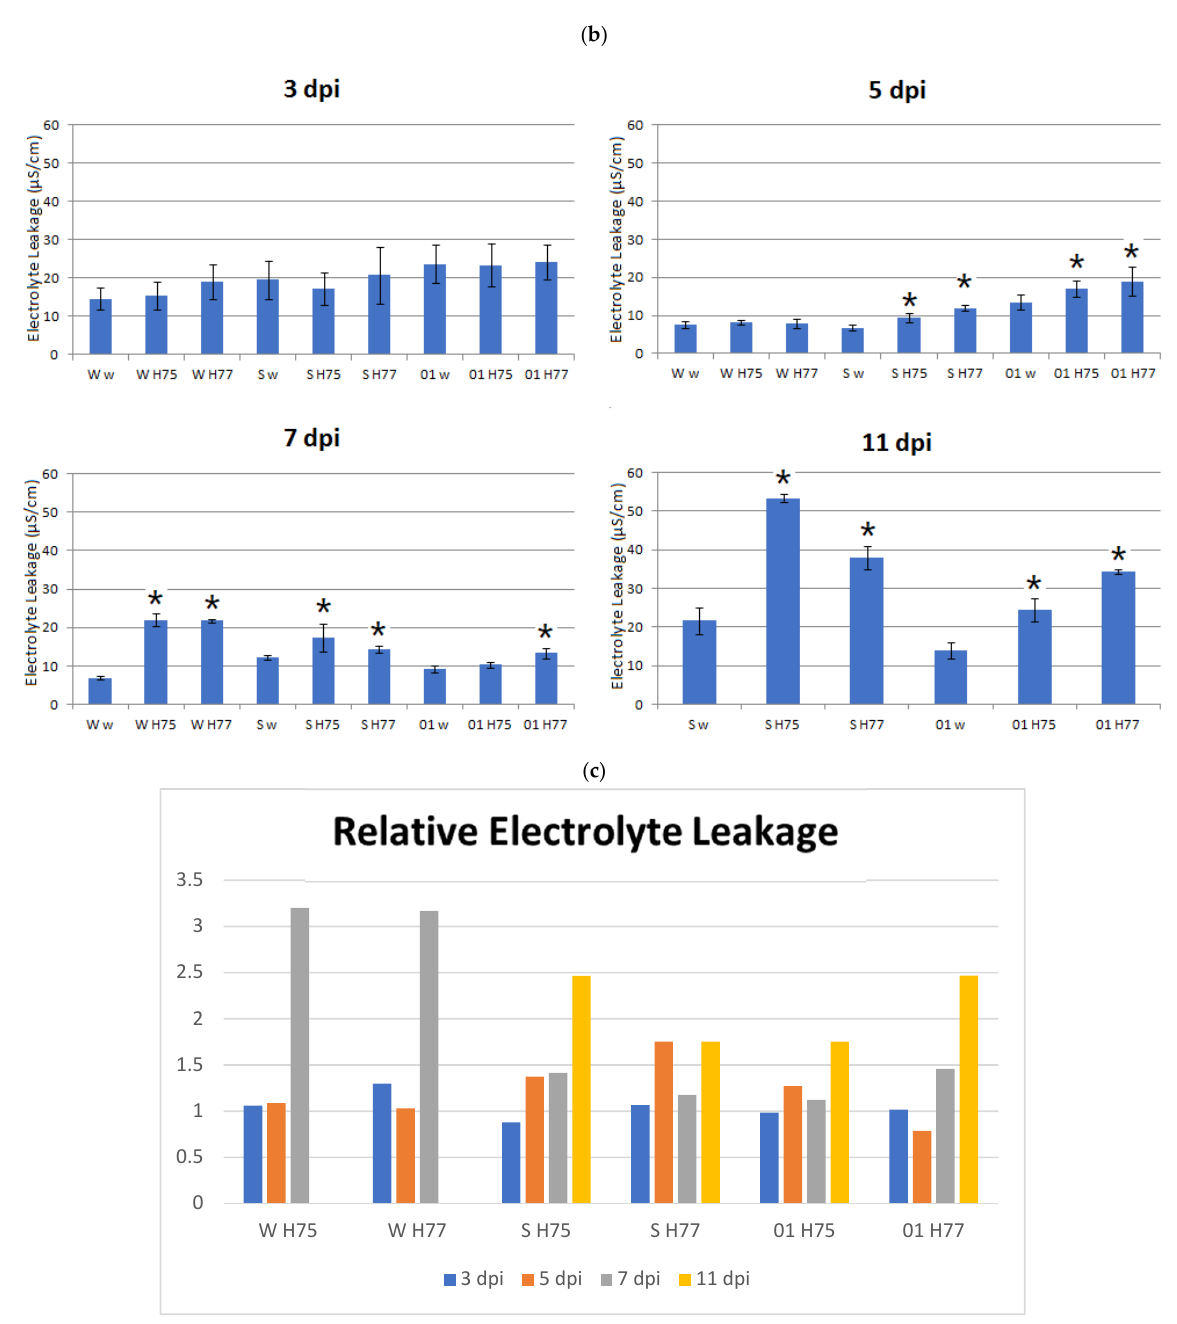
Figure 1. ( a ) The lesion development and the appearance of phenotypes were observed from the three genotypes (Westar, Surpass400 and 01-23-2-1) and two isolates (H75 8-1 and H77 7-2) at 11 days post-inoculation (dpi). ( b ) The measurement of electrolyte leakage at 3, 5, 7, and 11 dpi. At 11 dpi, because Westar cotyledons were generally degraded and heavily infected, the measurement of electrolyte leakage at this stage became incapable and inaccurate, the measurement of Westar genotype at this time point was not included. The x-axis indicates the inoculation pair between genotypes (W: Westar; S: Surpass400; 01: 01-23-2-1) and isolates (w; water; H75: H75 8-1; H77: H77 7-2), the y-axis indicates the voltage detected from the cotyledon-soaked solution suggesting the leaking of ions (unit: µS/cm, S; Siemens). The asterisks indicate the significant differences of the electrolyte leakage measurement among mean values when compared with mock inoculation (Fisher’s Least Significant Difference; p < 0.05). ( c ) The relative electrolyte leakage at 3, 5, 7, and 11 dpi. The relative leakage is calculated by dividing the average measurements of inoculated cotyledons by mock inoculated ones. For time point, different lowercase letters suggest the significant differences among mean values (Fisher’s Least Significant Difference; p < 0.05). The results are based on three replicates in three independent experiments.